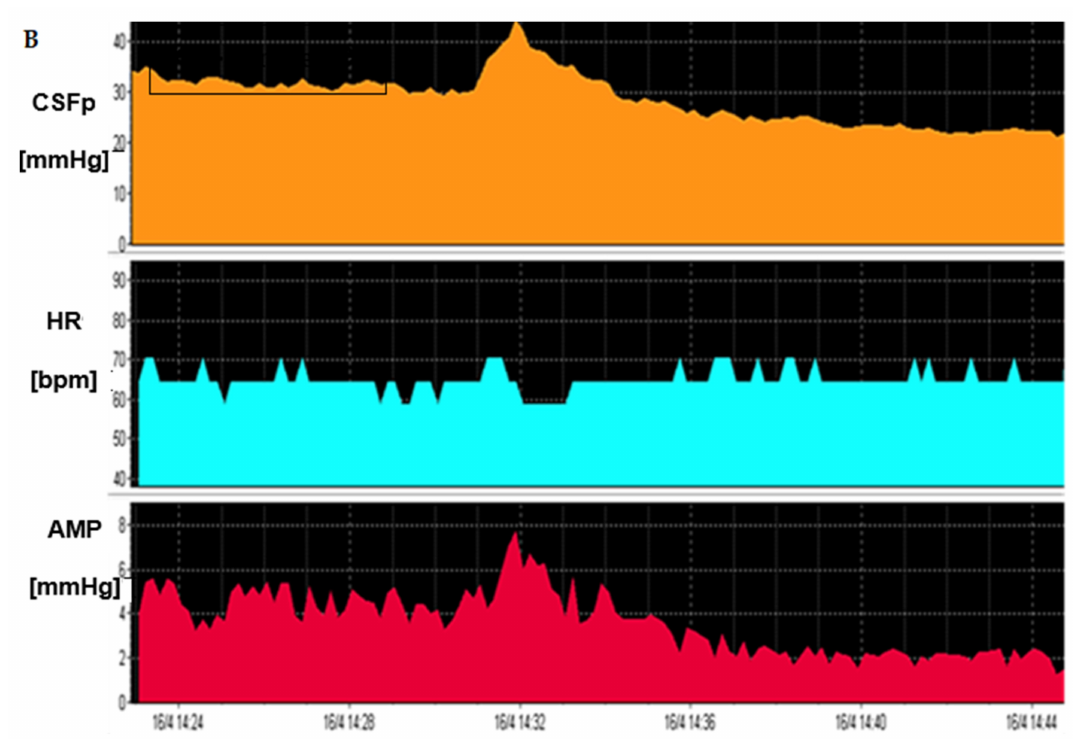
Figure 2. Variability of Intracranial pressure. ( A ): ICP recording (prolonged baseline, no infusion) of a patient with communicating hydrocephalus after SAH. Note regular fluctuation of ICP level from relatively “normal” range of 15–18 mmHg to abnormal waves of >60 mmHg in intervals of 15–20 min, most probably plateau waves of ICP. ( B ): change of ICP reading again from an initial level of 32 mmHg to 22 mmHg over a 10–20 min period in a paediatric patient. Both examples illustrate that ‘ICP is more than the number, and its value may change from normal baseline to high values in a matter of minutes. HR: Heart rate. CSFp: CSF pressure (when ICP not measured with an intraparenchymal